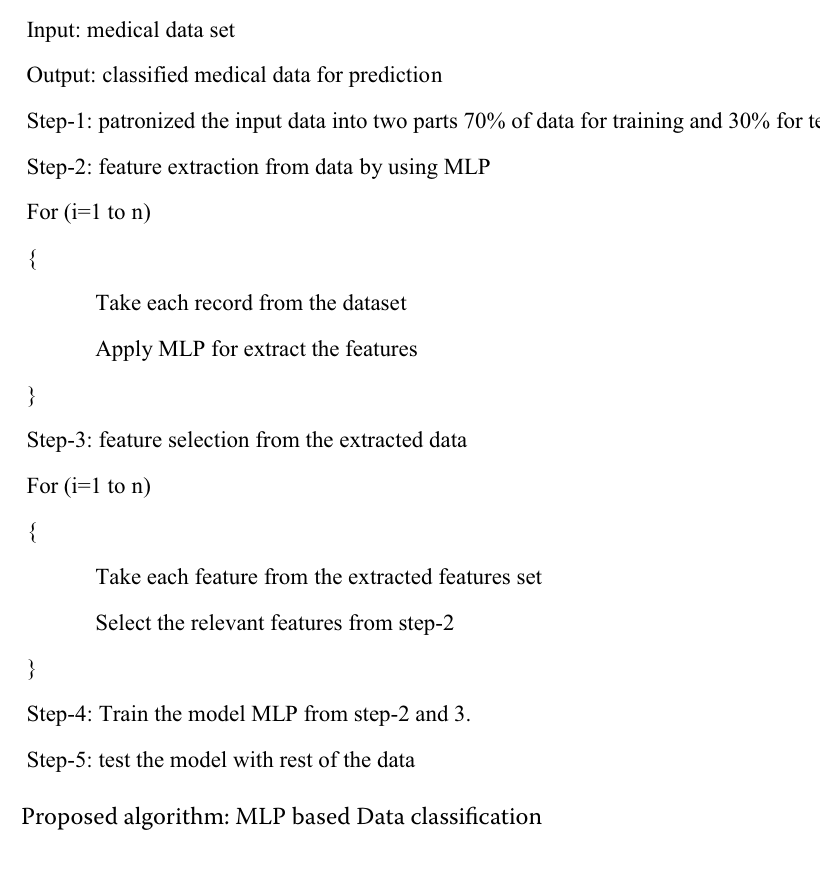
Proposed algorithm: MLP based Data